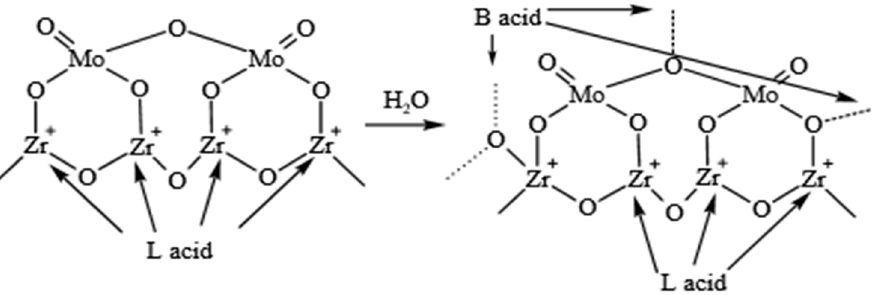
Figure 12. The acid center model of MoO 3 /ZrO 2 .